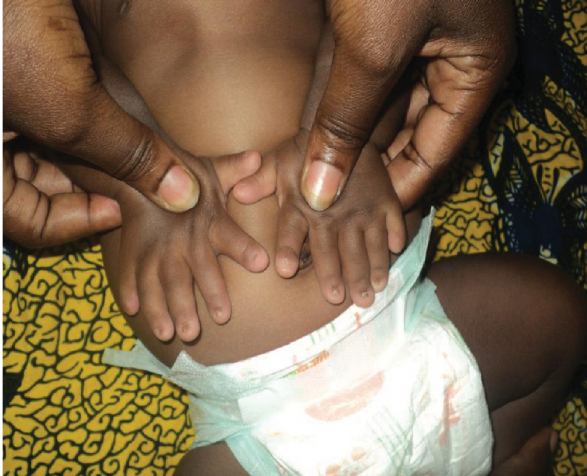
Fig. 2. Hands polydactyly and dystrophic nails.